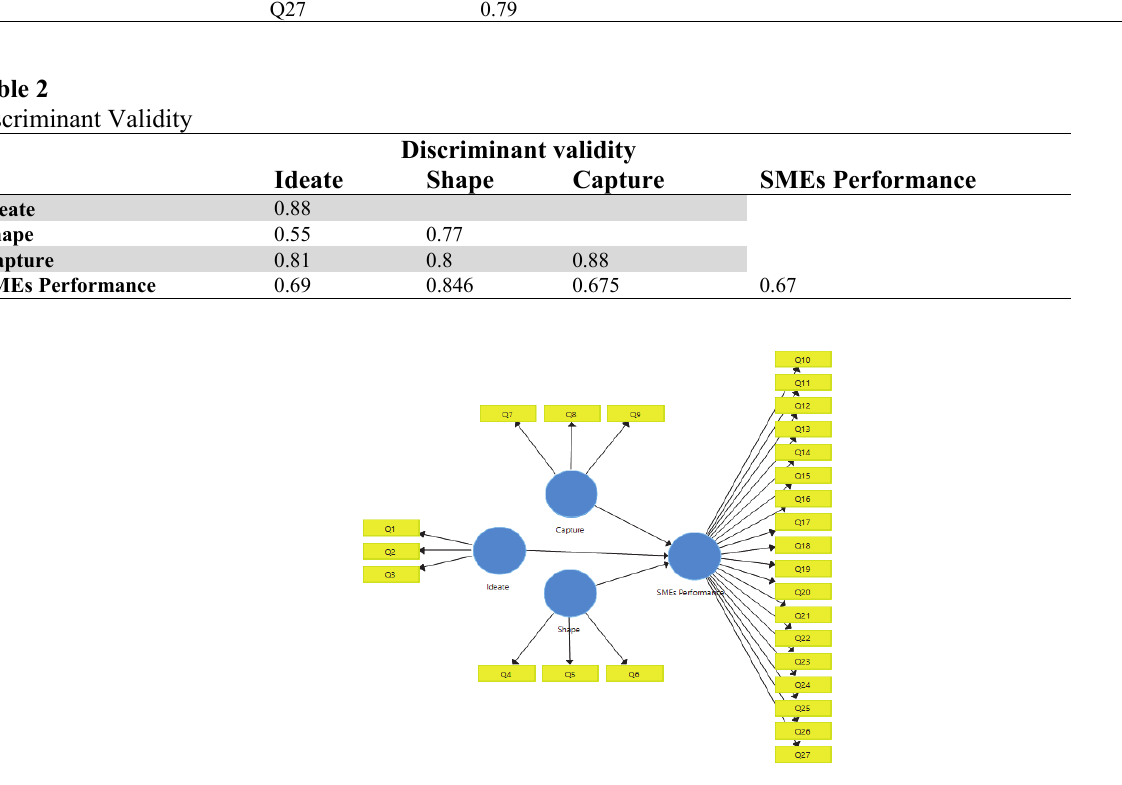
Fig. 2. Measurement